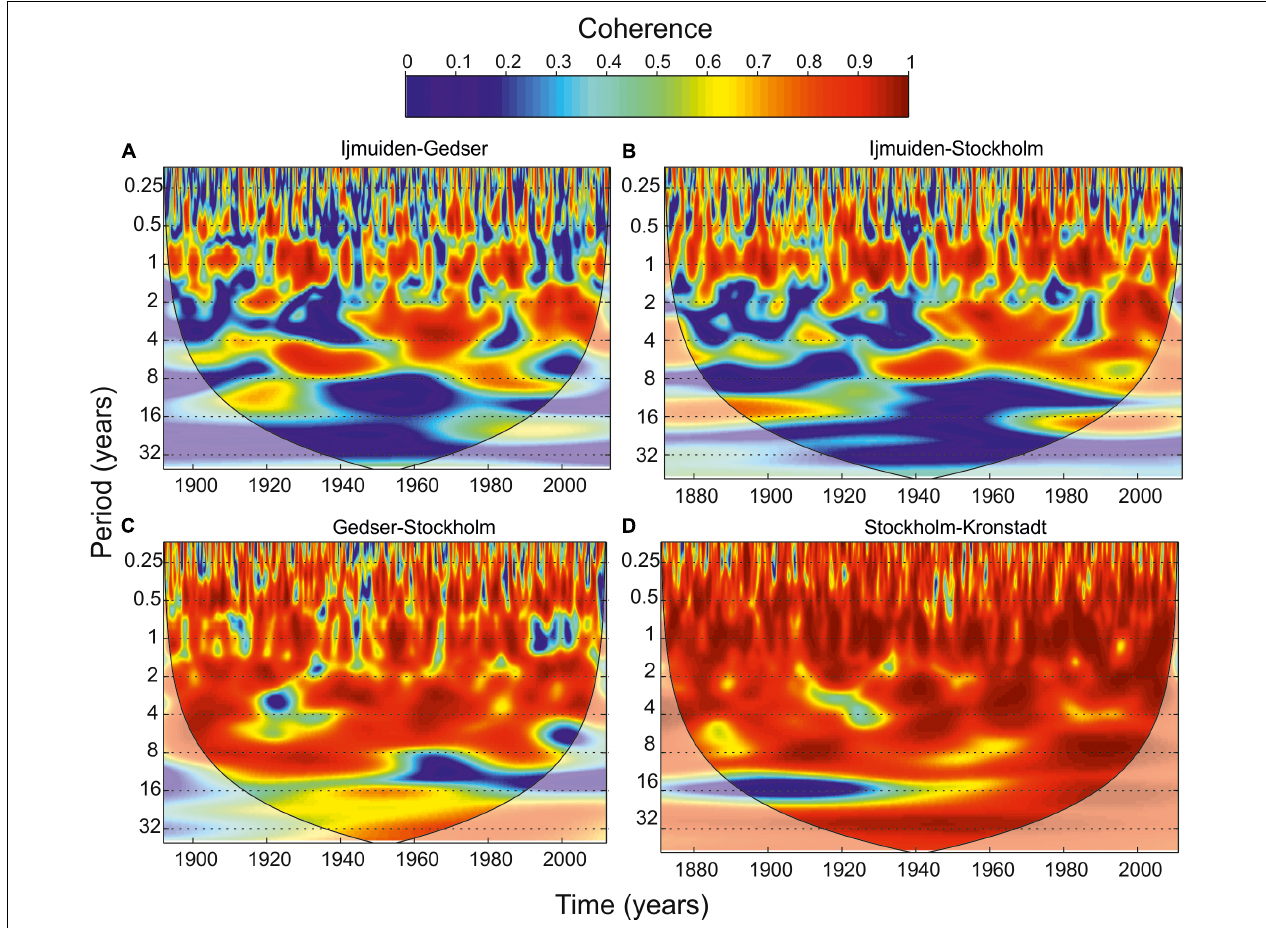
FIGURE 4 | Wavelet coherence between (A) IJmuiden–Gedser, (B) IJmuiden–Stockholm, (C) Gedser–Stockholm, (D) Stockholm–Kronstadt. In all panels, the black thin line is the cone of influence where edge effects might distort the picture, shown in a lighter shade.